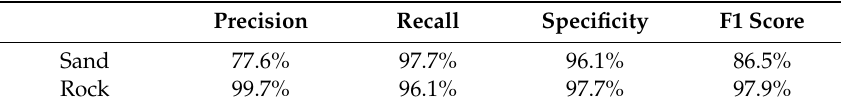
Table 7. Performance metrics of the terrain classifier. Table 8. Performance metrics of the slippage classifier.